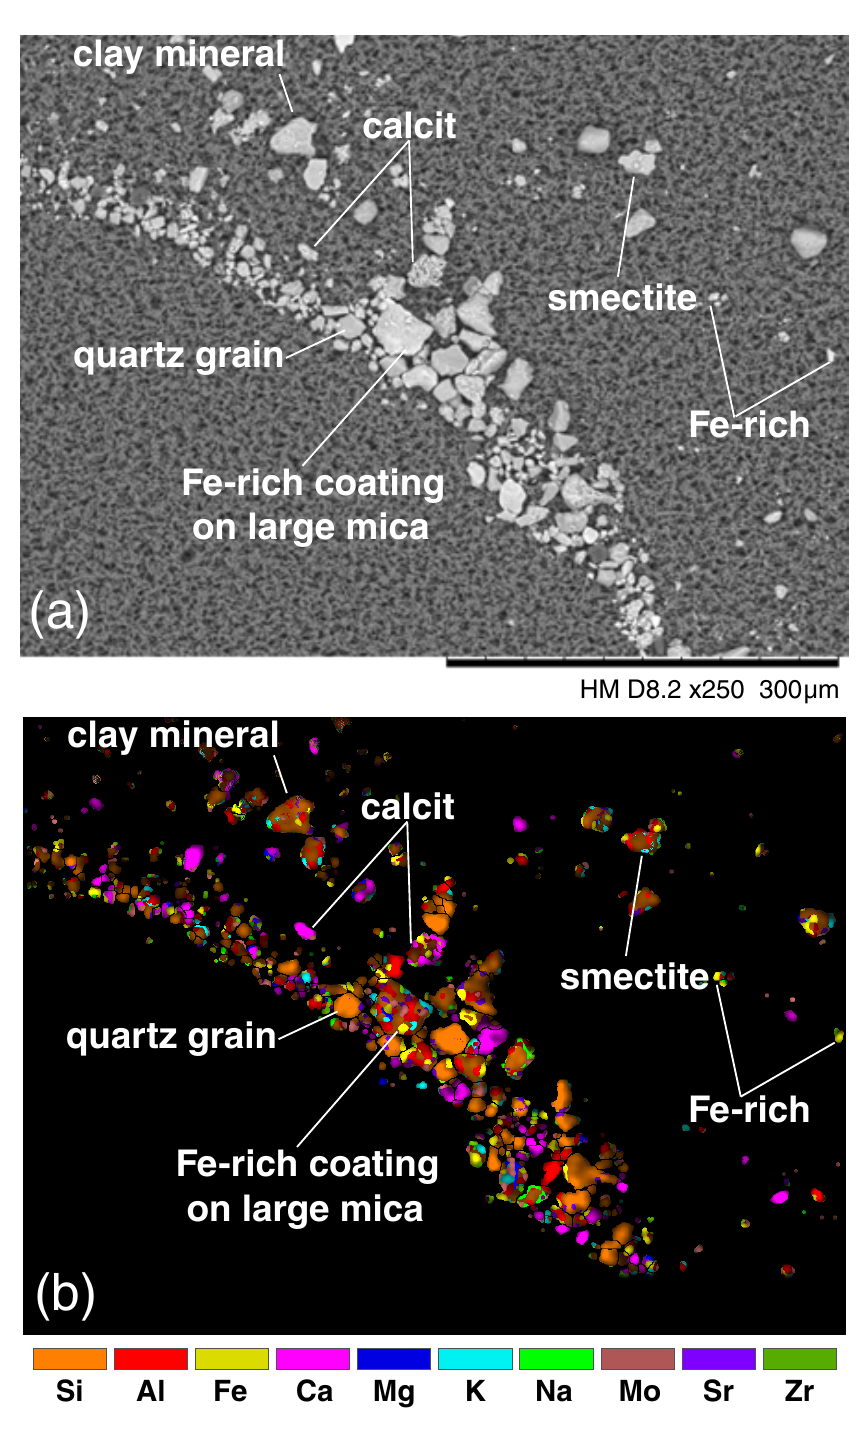
Figure 3. Saharan dust deposited on carbon filter visualized using ( a ) scanning electron microscope; and ( b ) Energy-dispersive X-ray spectroscopy. In ( b ) the image was obtained using all elemental pixel values maps. Based on elemental composition the calcite, quartz, and Fe-rich particles were